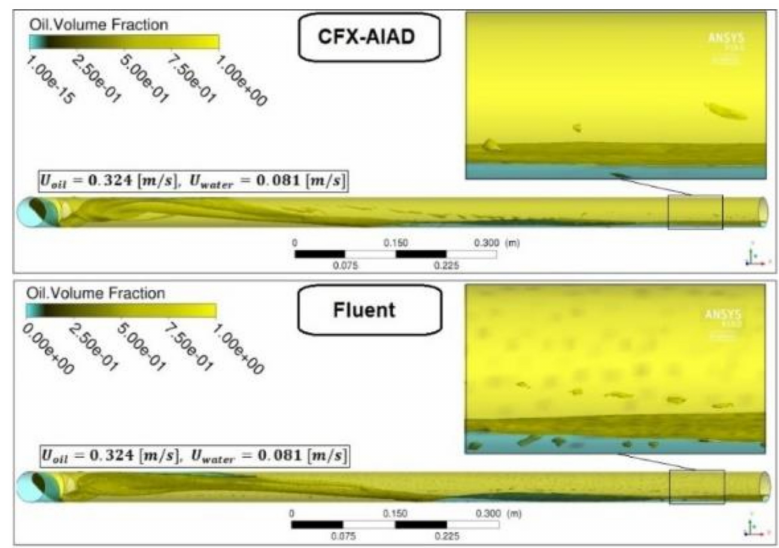
Figure 13. Oil volume fraction in the entire domain at U oil = 0.324 m / s and U water = 0.081 m / s.